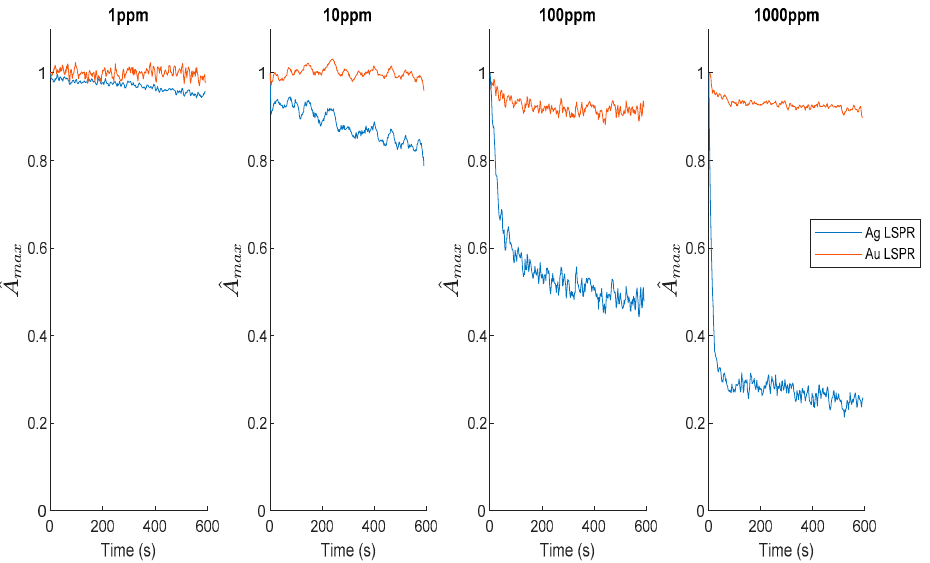
Figure 9. Sequential exposition of the optical fiber sensors to specific H 2 O 2 concentrations of 1 ppm, 10 ppm, 100 ppm, and 1000 ppm, showing the variation of the LSPR band of AgNPs (blue plot) and the LSPR band of AuNPs (red plot), respectively.